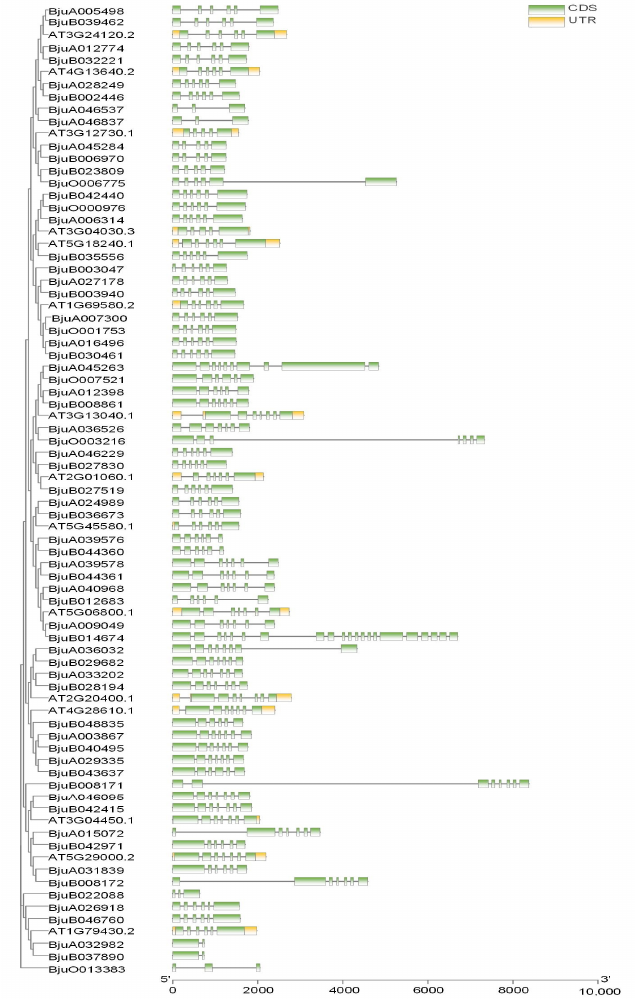
Figure 3. Schematic exon/intron structures of the MYB-CC genes from Brassica juncea and Arabidopsis thalina . Exon/intron organization of MYB-CC genes was visualized using the Gene Structure View (Advanced) from TB tools. The exons and introns are represented by green boxes and black lines, respectively. The UTR regions are indicated with yellow boxes. The length of CDS can be estimated by the scale at the bottom.